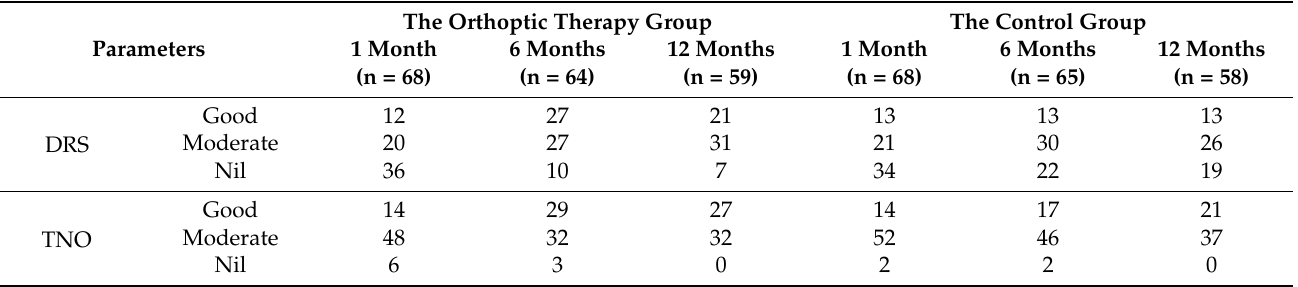
Table 4. Distribution of stereopsis subgroup in the orthoptic therapy group and control group at different follow-up visits.